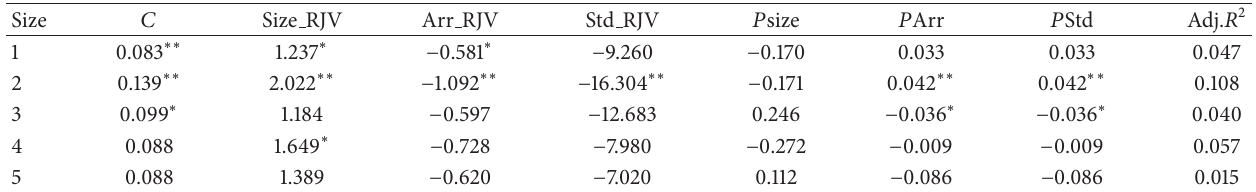
Table 8: Forecasting one-month-ahead individual-based portfolio returns using realized jump volatility-based factor model with market- level jump components.